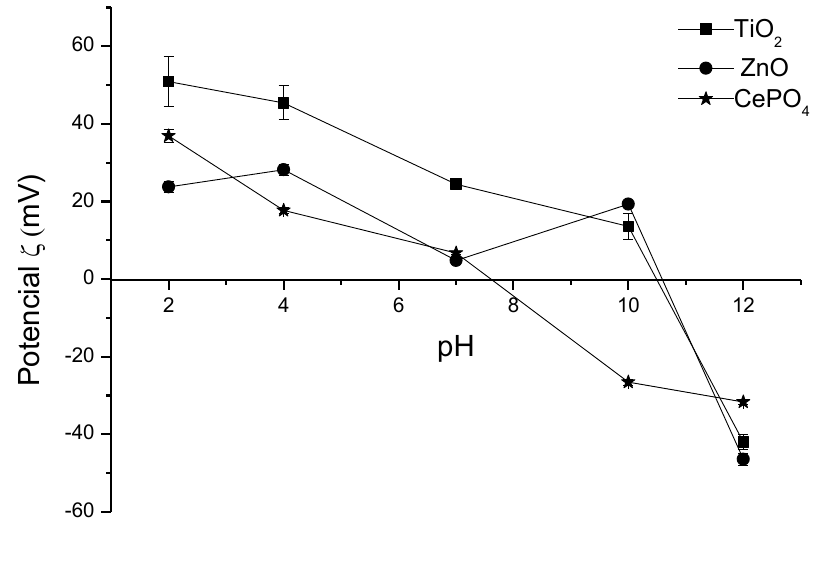
Figure 1. Zeta potential measurements of the inorganic UV